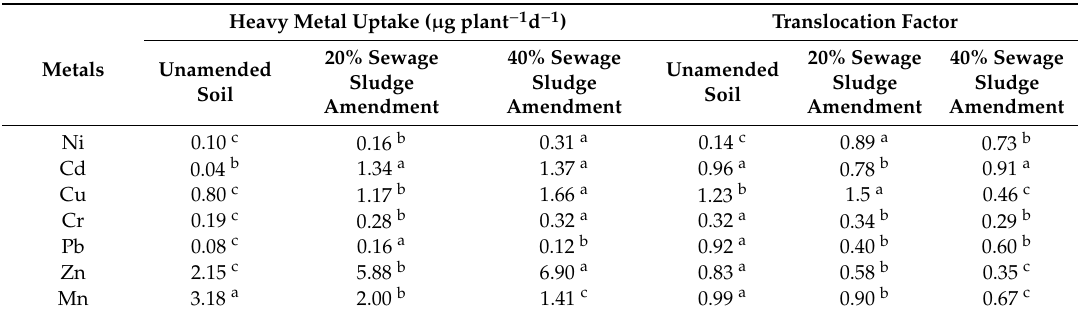
Table 4. Variations in heavy metal uptake rate and translocation factor of beetroot ( Beta vulgaris ) grown in unamended and sewage sludge-amended soils